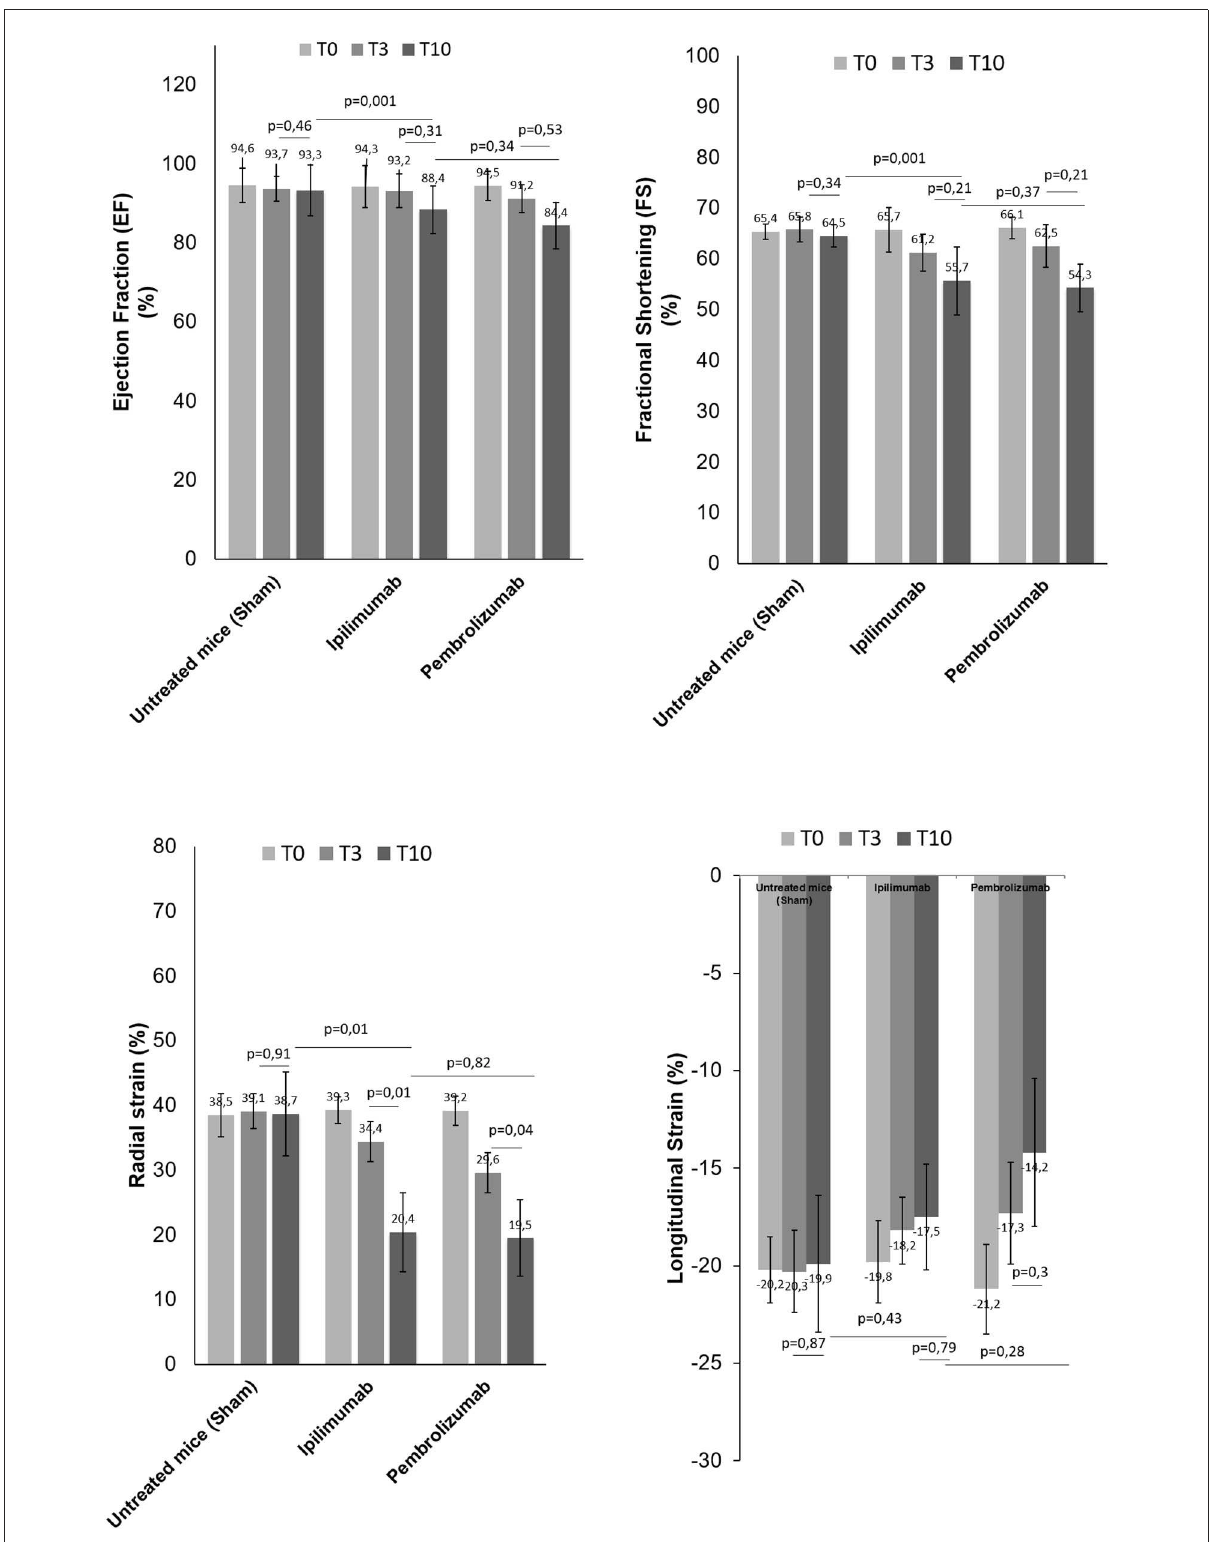
FIGURE3 Cardiac function studies. Before (T0), after 3 days (T3) and at the end of treatments (T10) with saline or Ipilimumab or Pembrolizumab (15 mg/kg/die), cardiac functions studies were performed. Ejection fraction (%) ( n = 6), fractional shortening (%) ( n = 6), radial ( n = 6) and longitudinal strain (%) ( n = 6) were analyzed through VEVO 2100 echocardiography. Error bars depict means ±